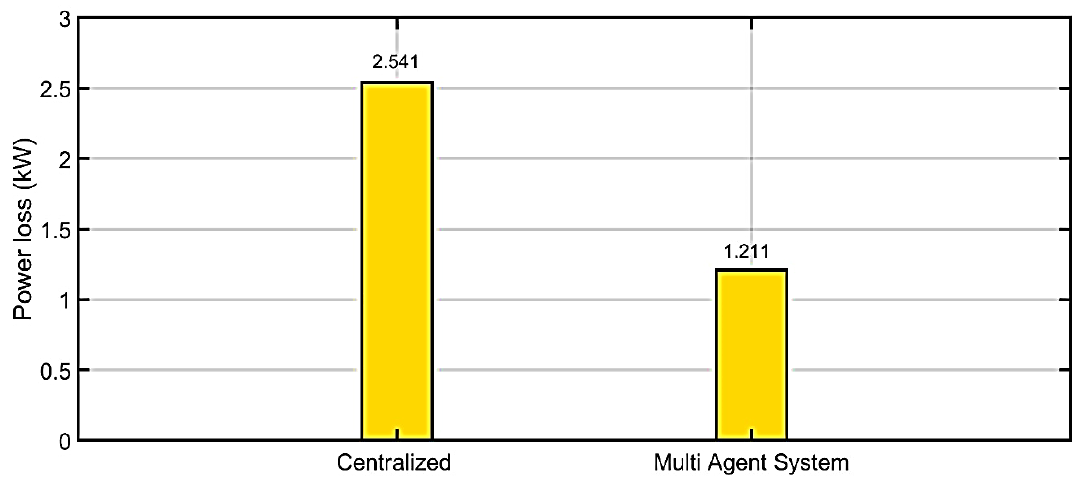
Figure 16. Comparison between power loss without proposed method and with proposed method.